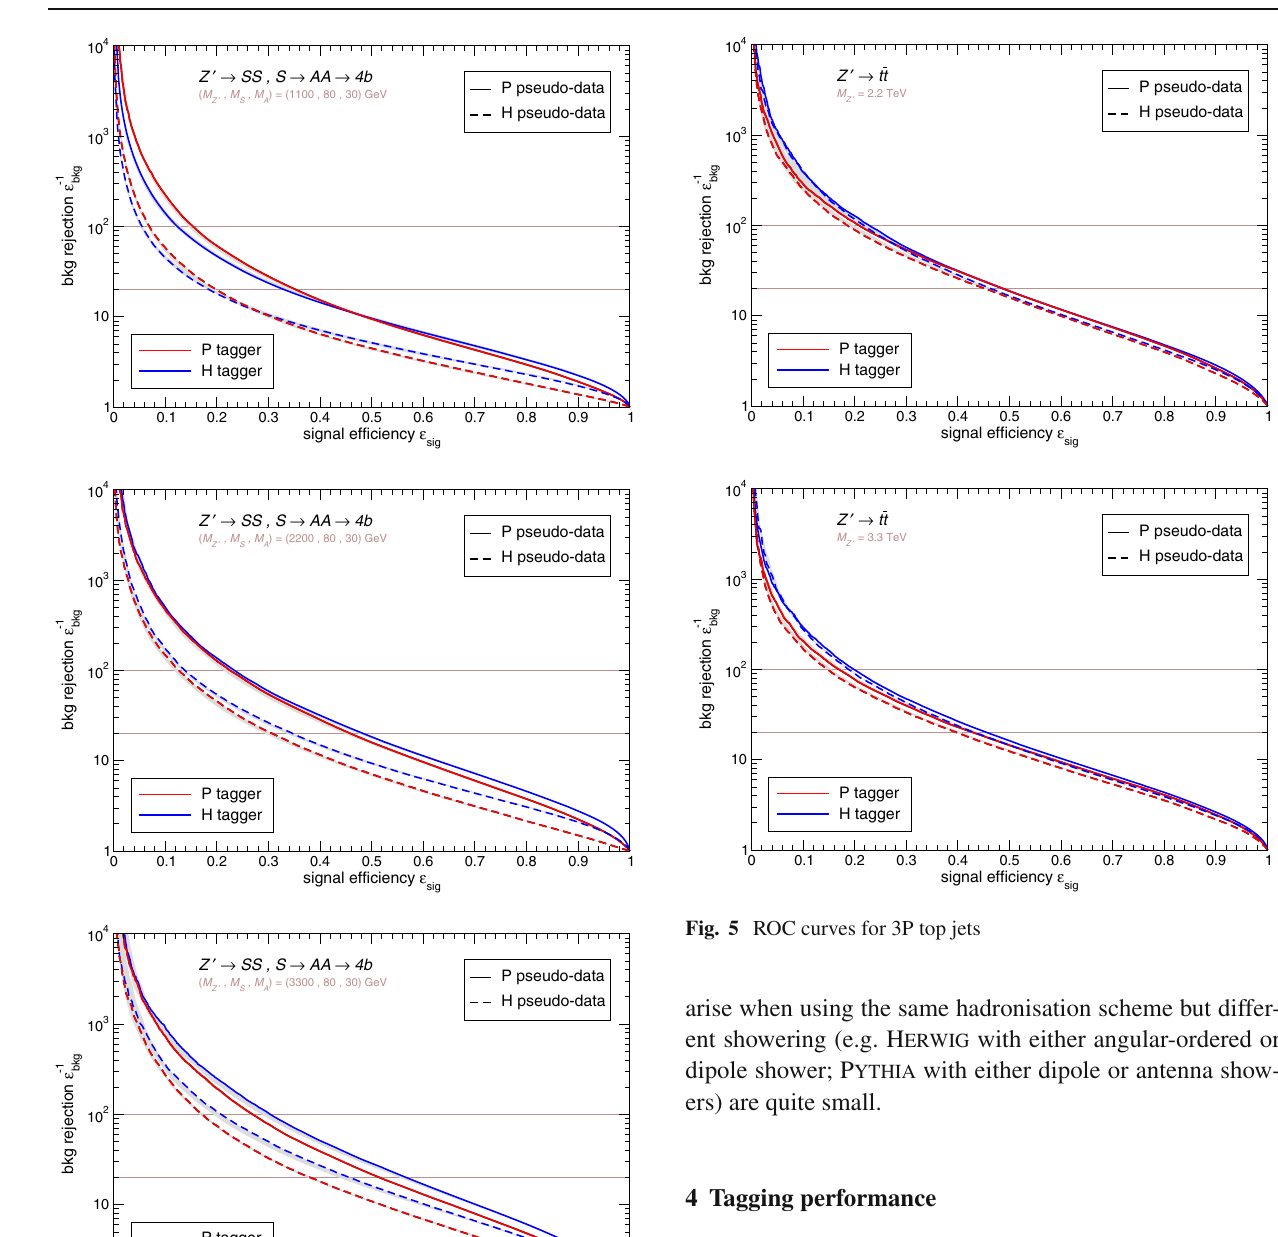
towards larger values for 2P and 4P jets. This fact indicates that in 2P and 4P jets the subjets are less resolved, and is in agreement with Ref. [20], which shows for W jets that Her- wig with angular-ordered shower produces more radiation between the subjet cores, which are therefore less resolved. This pattern suggests that the discrepancy is mainly due to the hadronisation scheme, rather than parton showering. The results in Ref. [20] confirm this point: the differences that